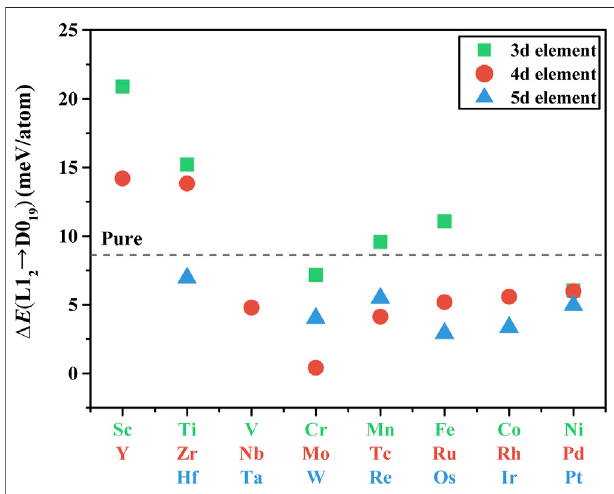
FIGURE 3 | Calculated structure transition energy of X-substituted γ ′ - Co 3 (V, Ta), where 3d-, 4d-, and 5d-elements are denoted by square, round, and triangle, respectively.